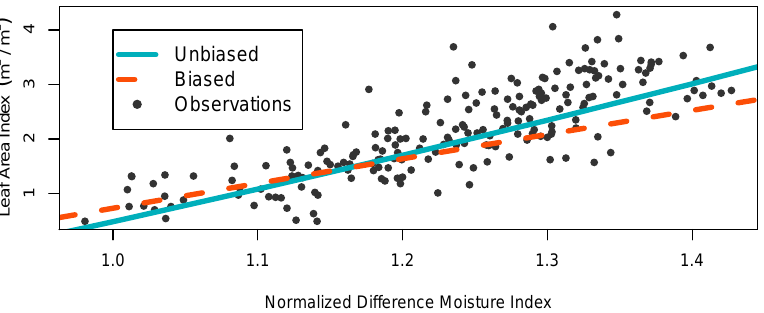
Figure 9. Comparison of the unbiased (Equation (4)) and biased model parameter fits for the unfertilized (FERT = 0) segment of model